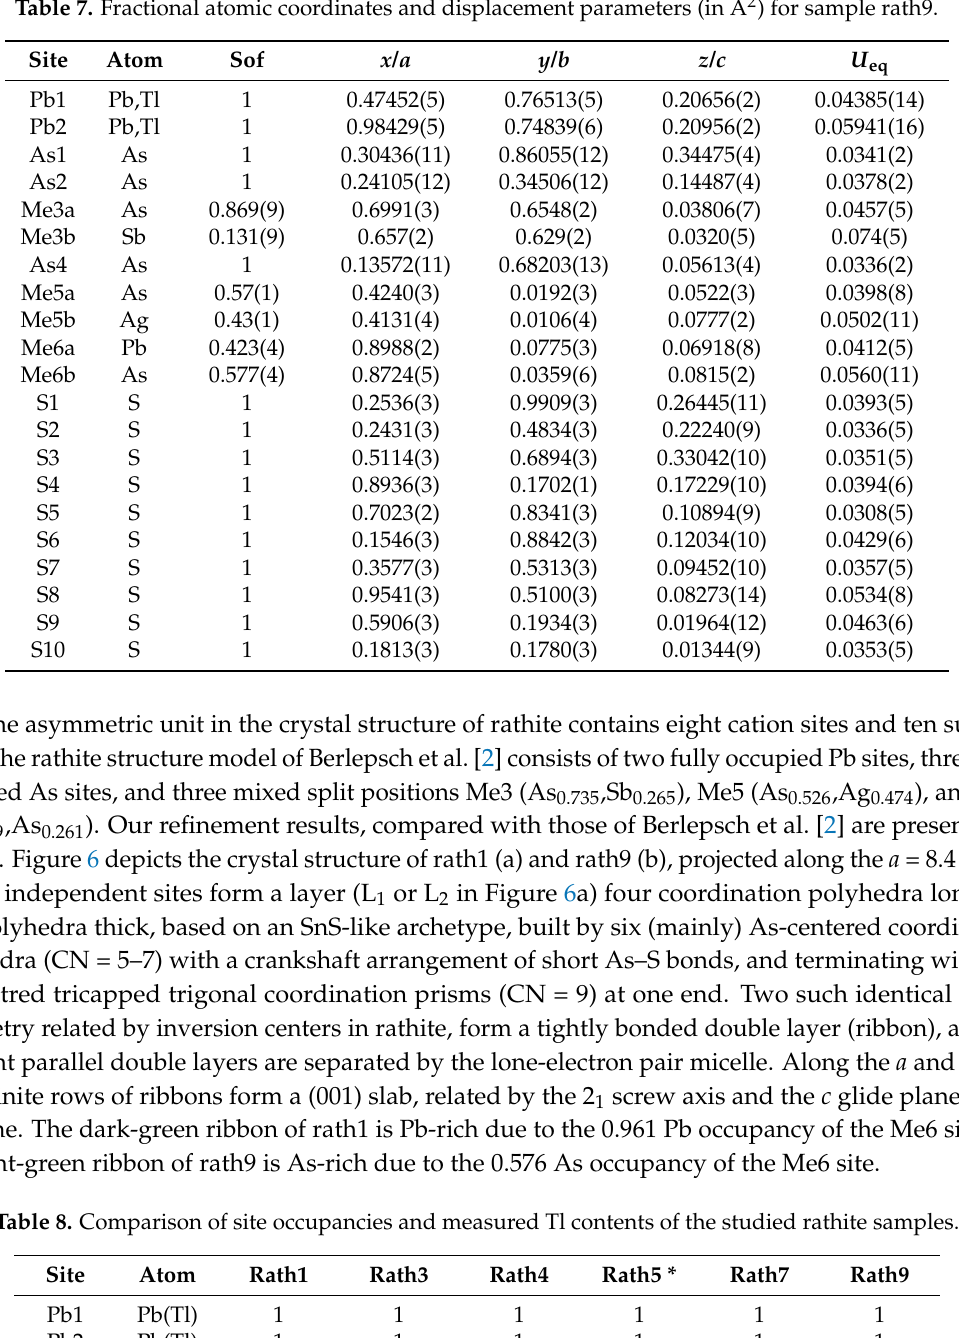
Table 7. Fractional atomic coordinates and displacement parameters (in Å 2 ) for sample rath9.